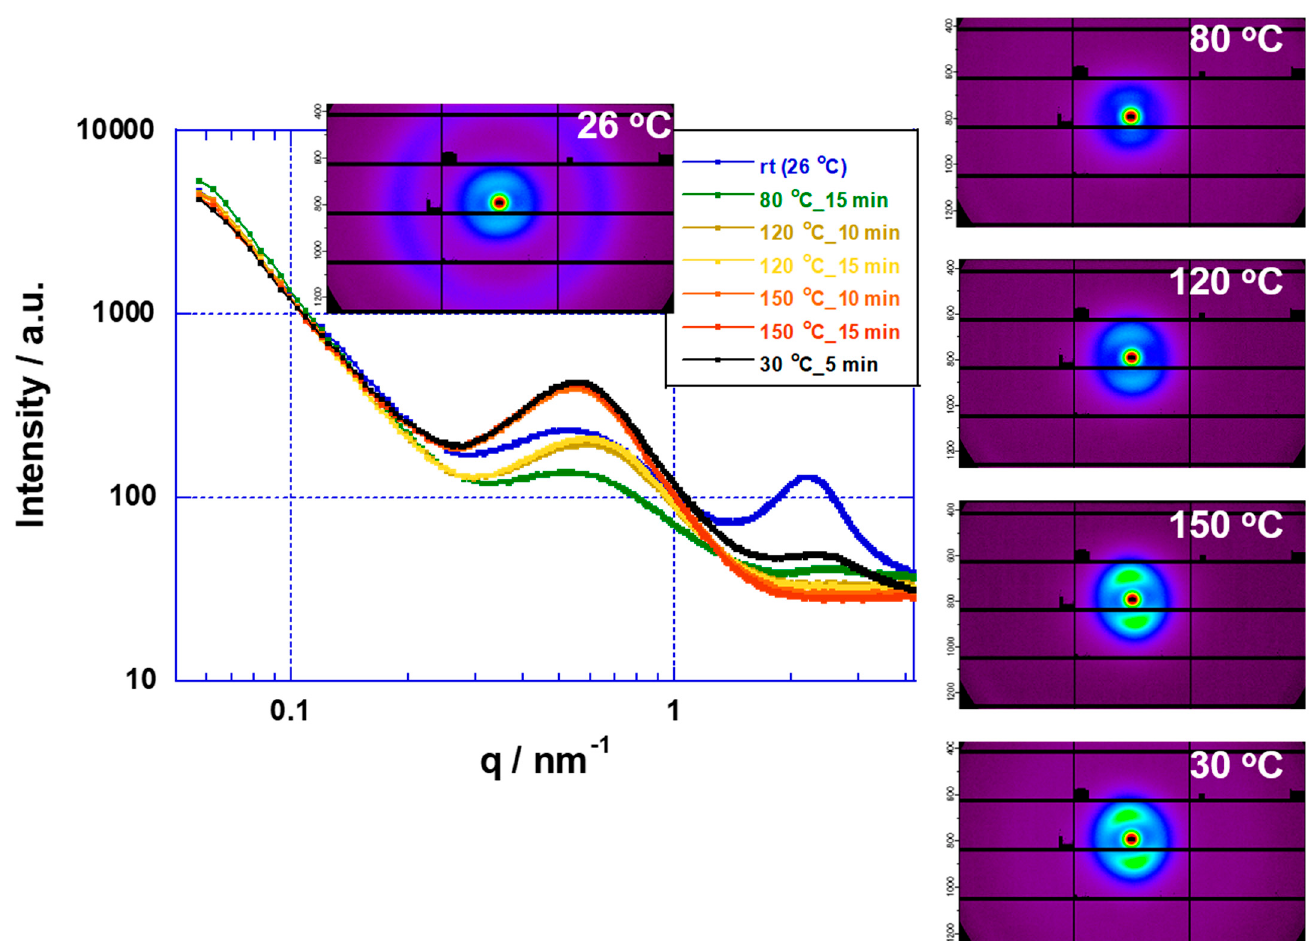
Figure 7. SAXS profiles of Aquivion membrane at various temperatures.